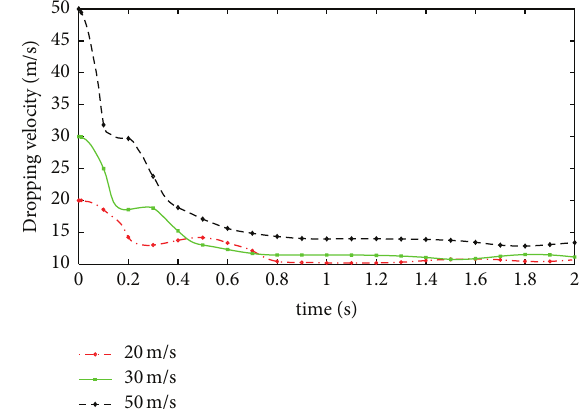
Figure 8: Parachute-load system’s velocity comparison versus